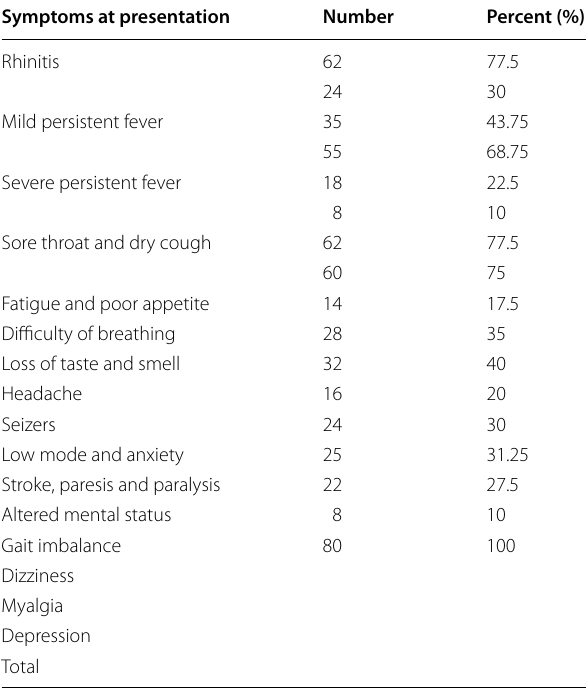
Table 2 Symptoms at presentation and no. (%) of studied patients